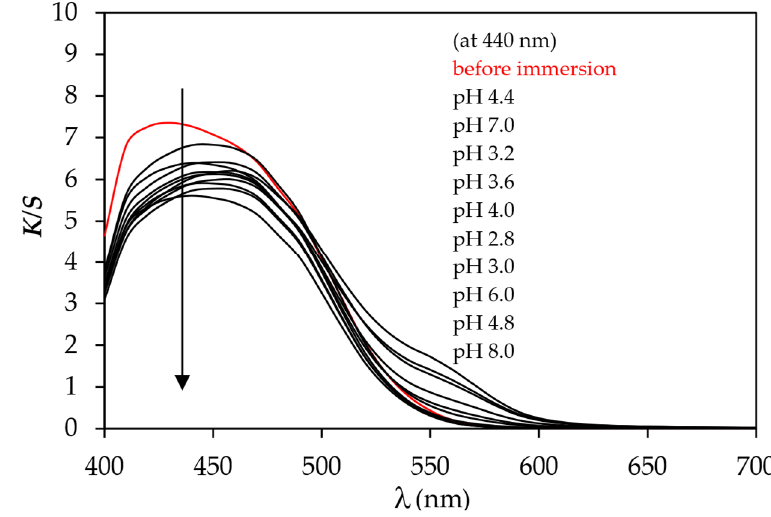
Figure 7. Values of K / S in dependence of the wavelength ( λ ) of sample CT_CO_D_C at different pH values.